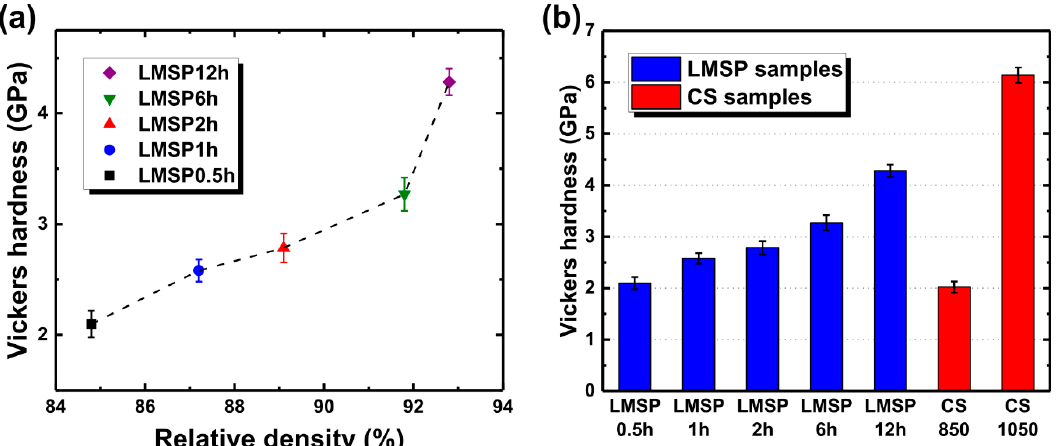
Figure 8. Vickers hardness of ( a ) LMSP samples against the relative density and ( b ) a comparison of the values for each fabrication condition of LMSP and CS samples.